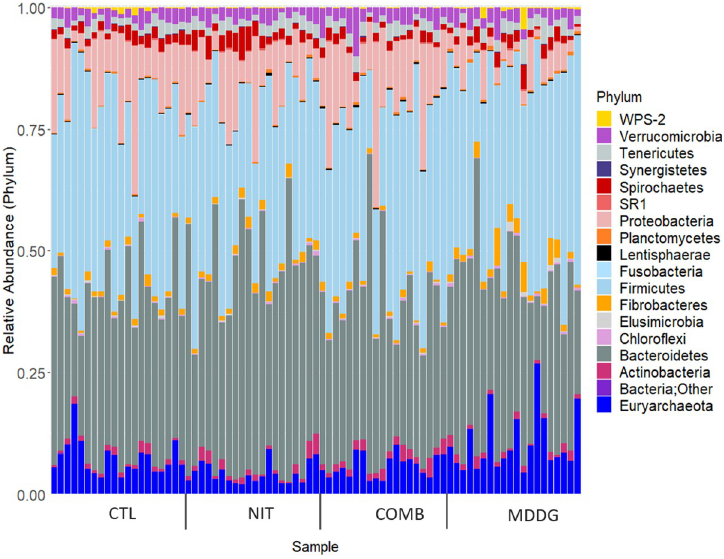
Fig 1. Taxa summary plot across the 4 dietary treatments (CTL, NIT, COMB, MDDG).